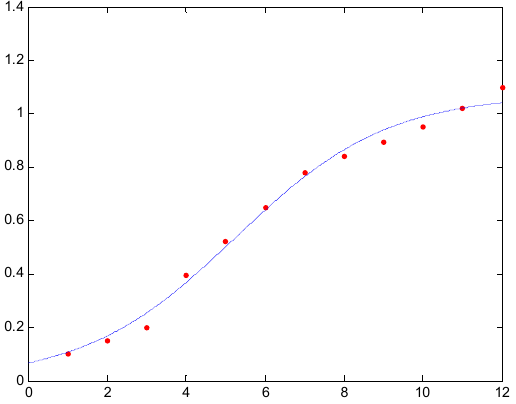
Figure 5. The correction parameter curve of past reputation.